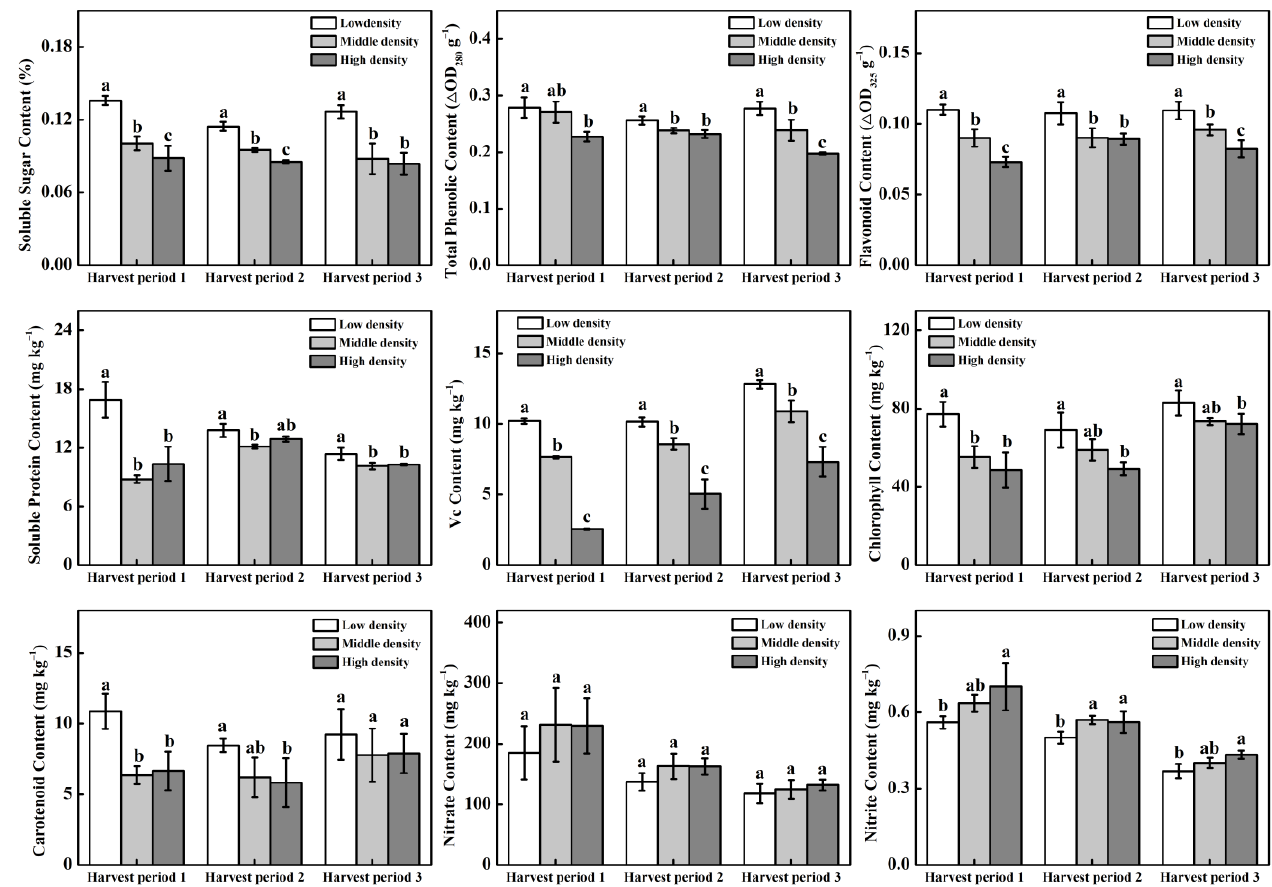
Figure 7. Cucumber fruit quality parameters for different density treatments in three cultivation periods. The data represent the mean ± SD (n = 3). Different letters indicate significant differences at α = 0.05 based on the Least Significant Difference (LSD) test.